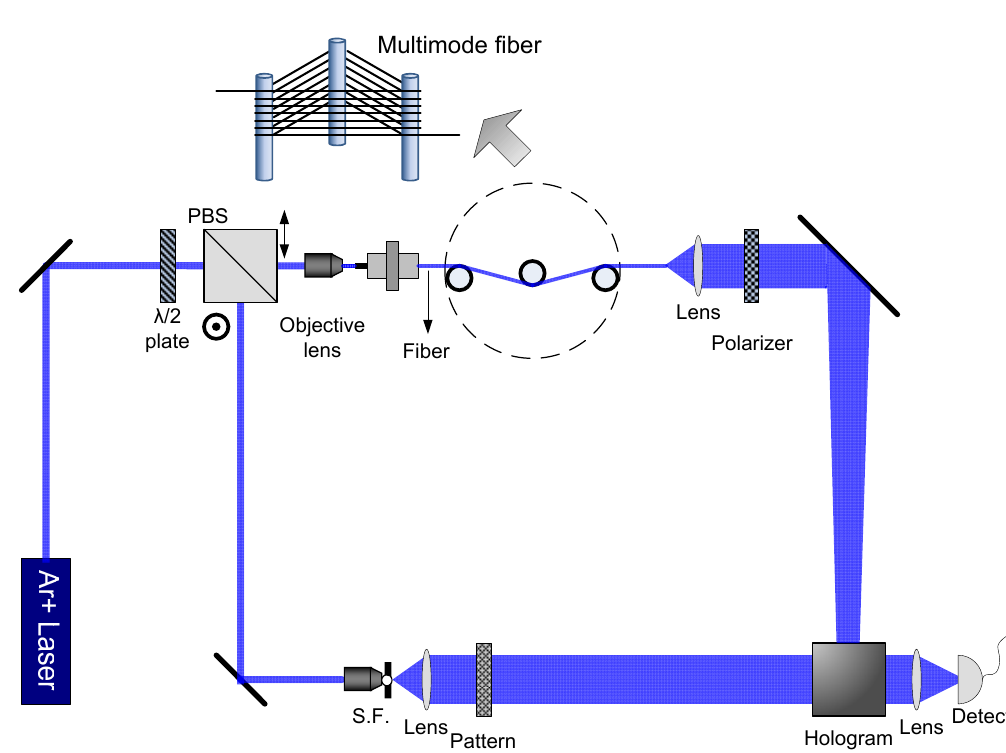
Figure 8. Schematic diagram of a fiber sensing system.